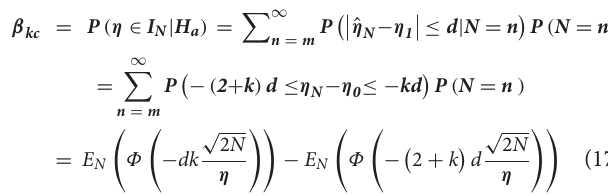
10, σ 5, η 2, γ 0.5, and 1 = = = =